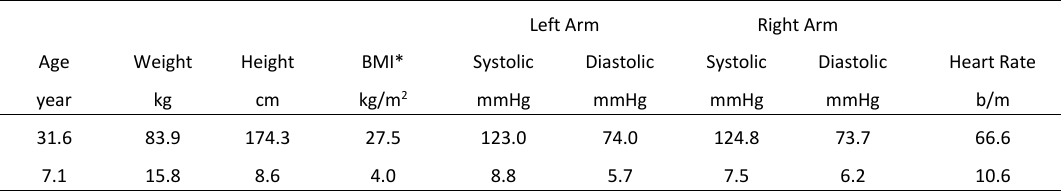
Table 1. Epidemiology of test subjects; n=14; mean (upper numerical row) and SD values (lower numerical row). The differences between left and right systolic and diastolic values were not significant. *Body Mass Index. Protocols were approved by an Institutional Review